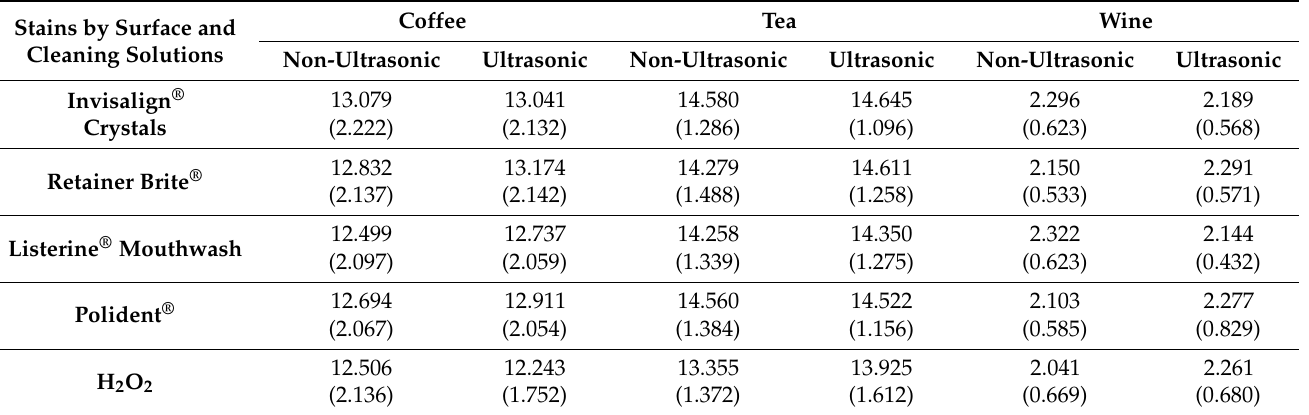
Table 8. NBS values for copolyester retainer specimens stained in coffee and tea solutions and then destained with five different cleaning solutions with or without the use of an ultrasonic cleaning cleaner unit (mean NBS value ± standard